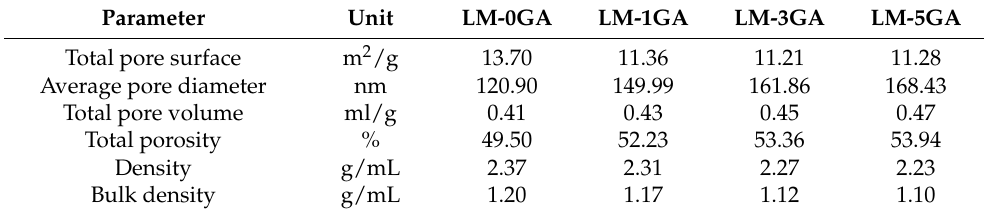
Table 4. The average results of the paste tests performed by means of mercury porosimetry.